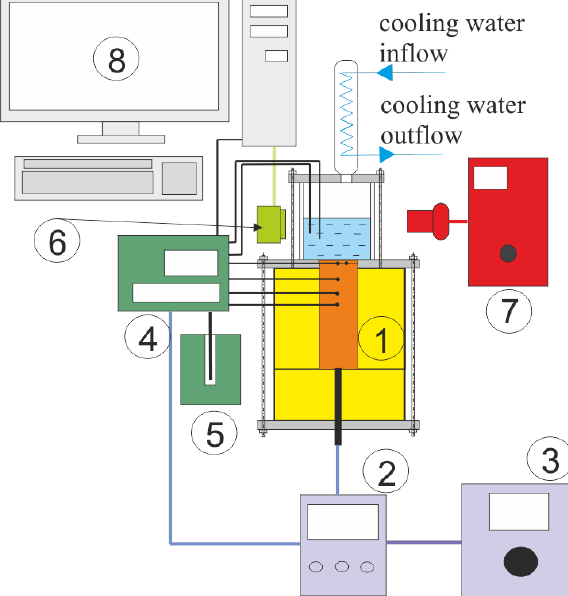
Fig. 1. Measurement system: 1 – main module, 2 – wattmeter, 3 – autotransformer, 4 – data logger , 5 – dry-well calibrator, 6 – high speed camera, 7 – lights, 8 – PC.